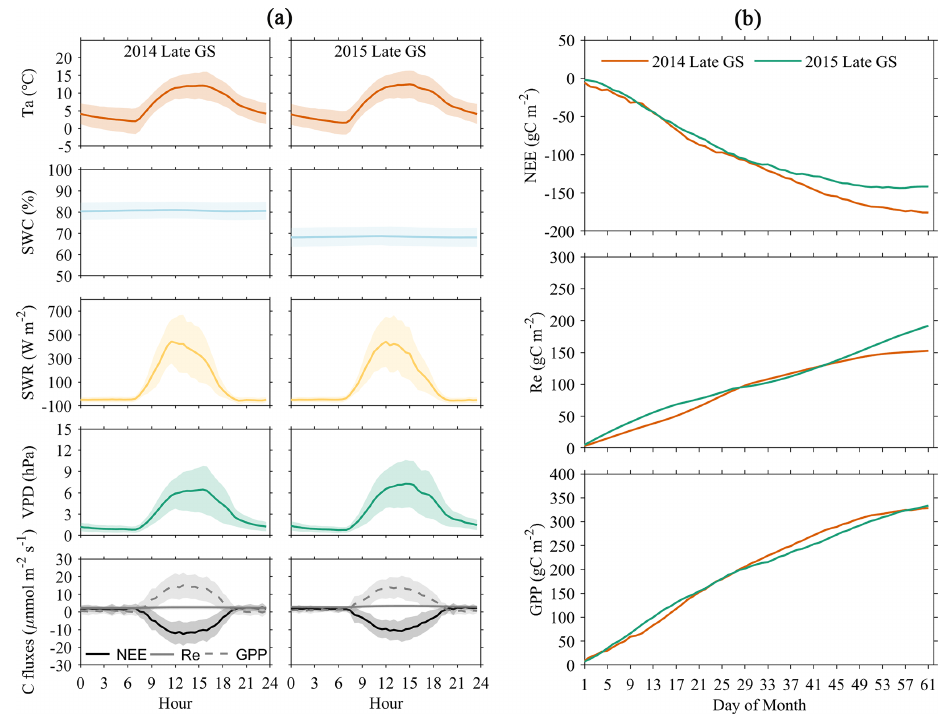
Figure 6. (a) Comparisons of the diurnal variations of environmental drivers (Ta, SWC, Rn, and VPD) and C fluxes (NEE, Re, and GPP) be- tween the late growing season of 2014 and 2015. The shading represents the mean ± standard deviation of the presented variables. (b) Com- parisons of the daily accumulated C fluxes (NEE, Re, and GPP) between the late growing season of 2014 and 2015. Note thats late GS represents late (August–September) growing